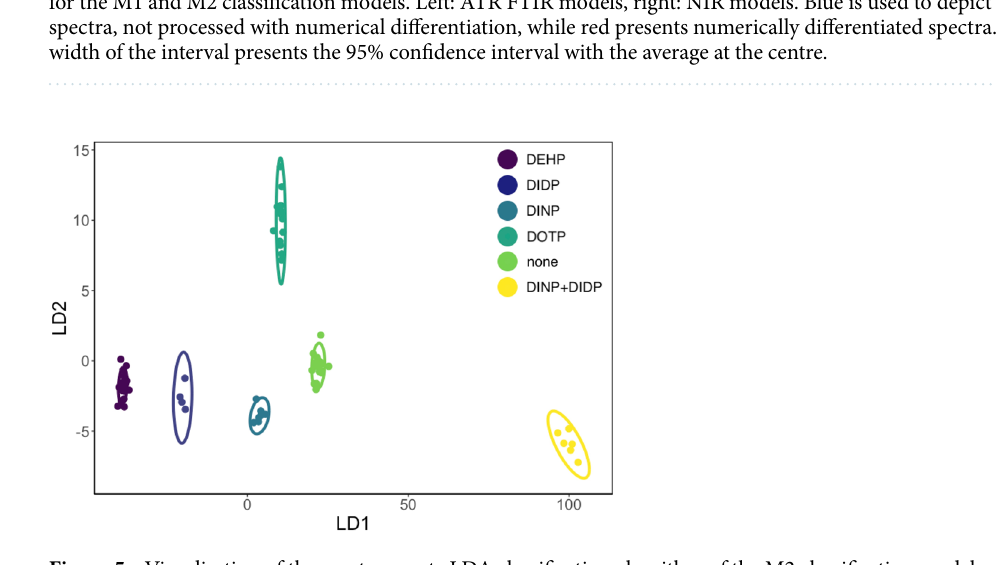
Figure 5. Visualisation of the most accurate LDA classification algorithm of the M2 classification model with ATR FTIR spectra, untreated with numerical differentiation (LDA ATR FTIR model